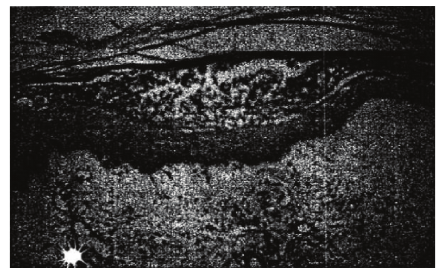
Figure 2: Superficial epidermolysis of the granular